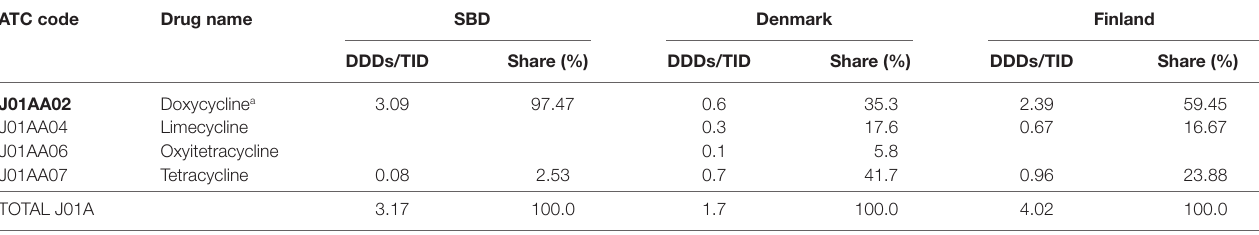
TaBle 4 | Utilization of antibiotics within tetracyclines subgroup (J01A) in South Backa District (SBD), Denmark and Finland in 2008. aTc code